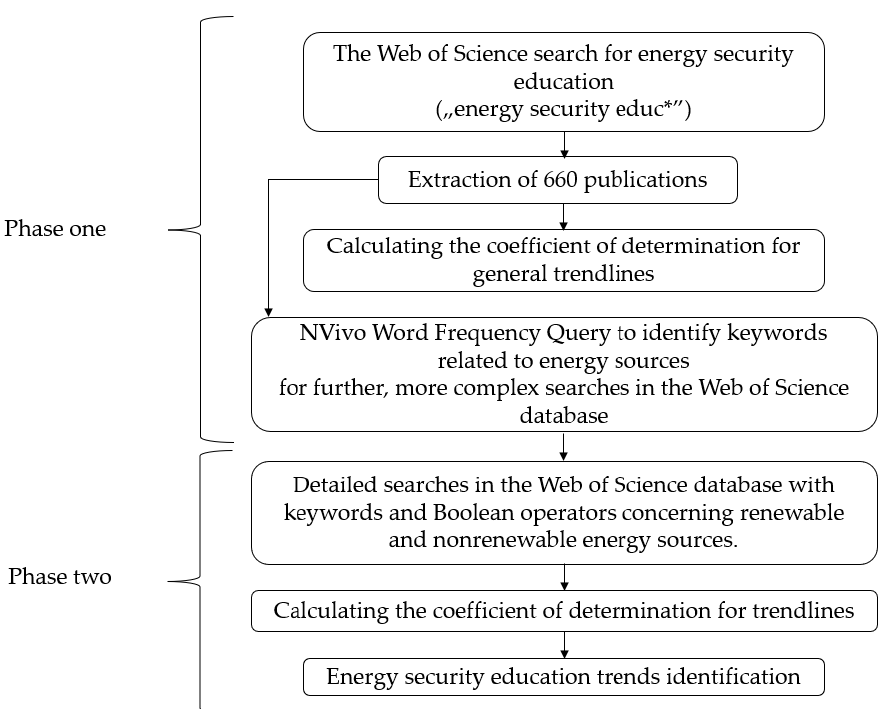
Figure 2. Research design for a text-mining and content analysis of publications on energy security education (Web of Science, 2016–2021).